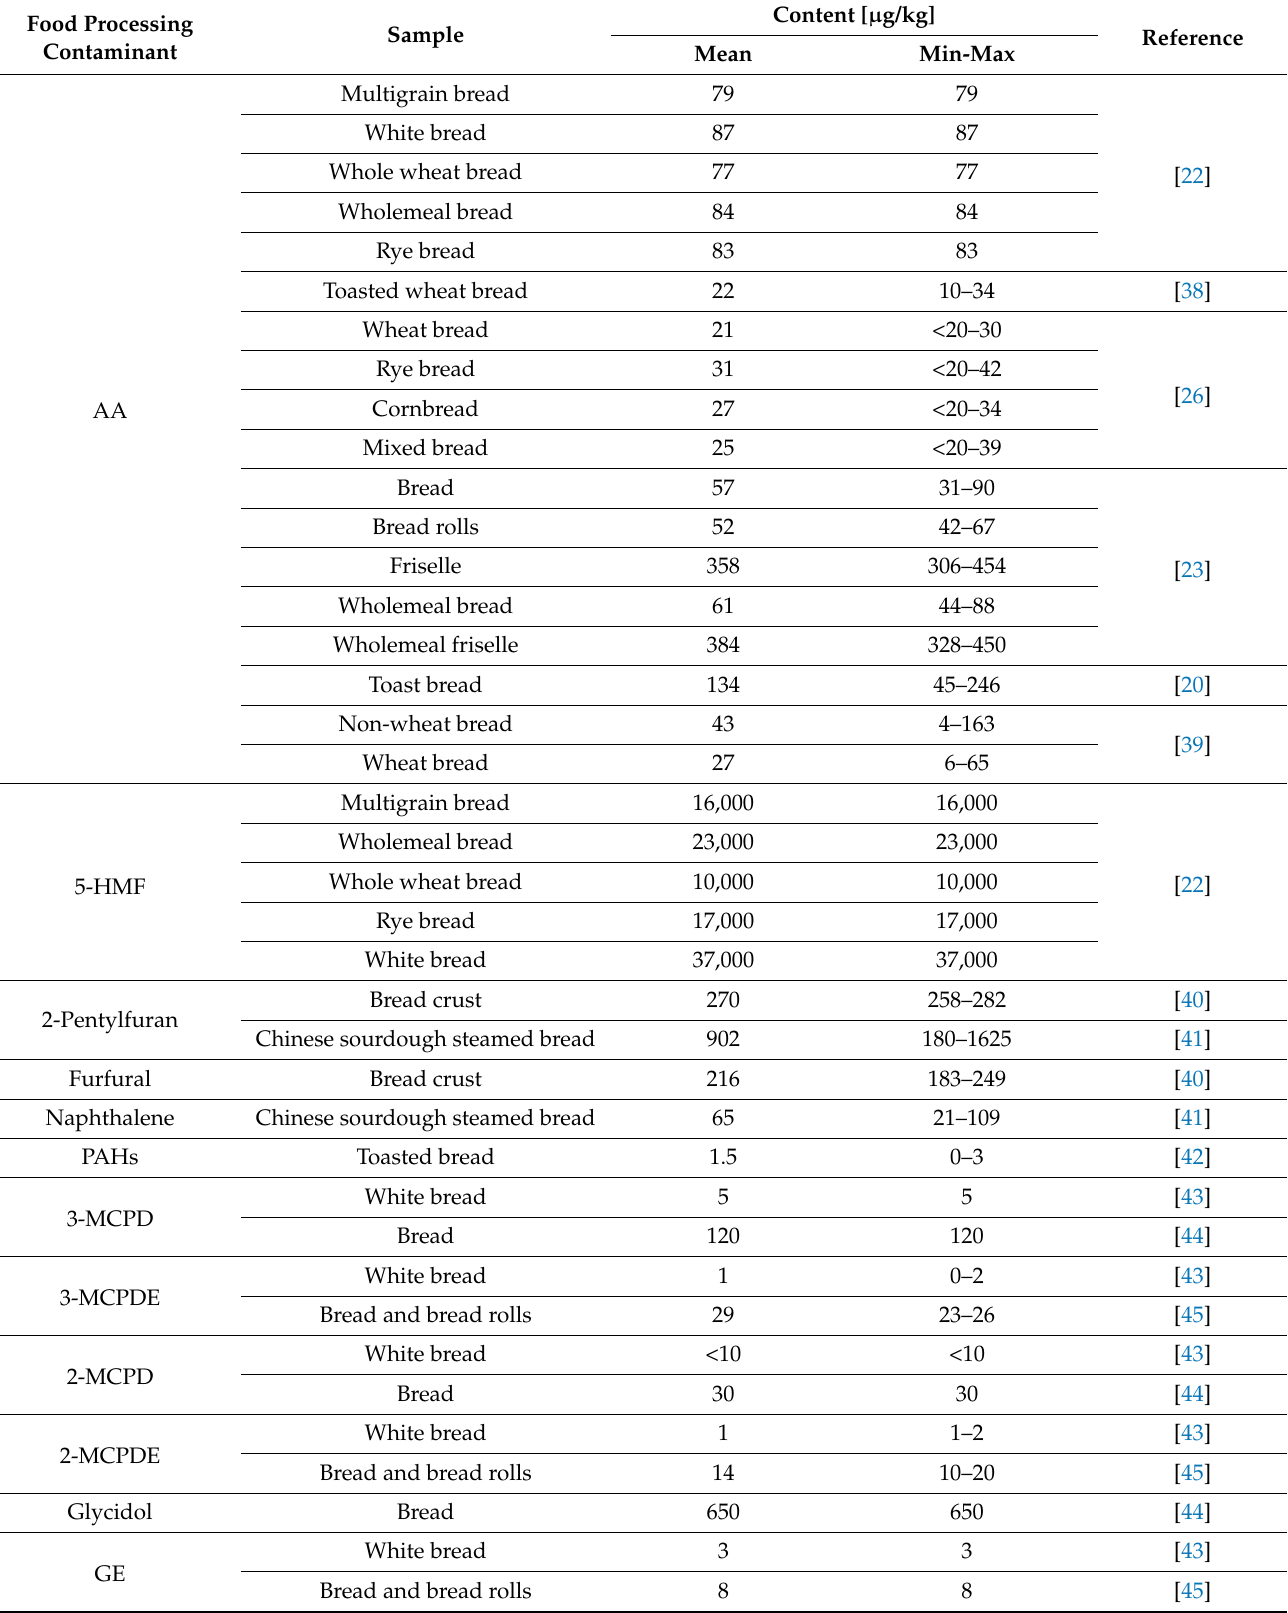
Table 1. Food processing contaminants contribute to various bread-related